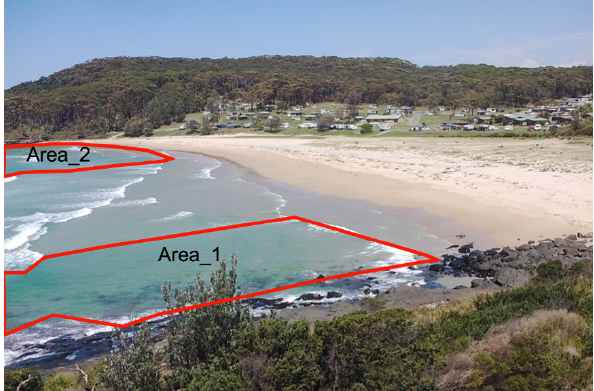
Figure 5. Photo of Merry Beach (taken from the remote camera) used to test beachgoers’ choice of swimming location with red polygons (Area_1; Area_2) indicating rip current locations. Re- spondents were shown a clean (and larger) image. Note that the image was not taken during the survey period. Image courtesy of Mitchell D.